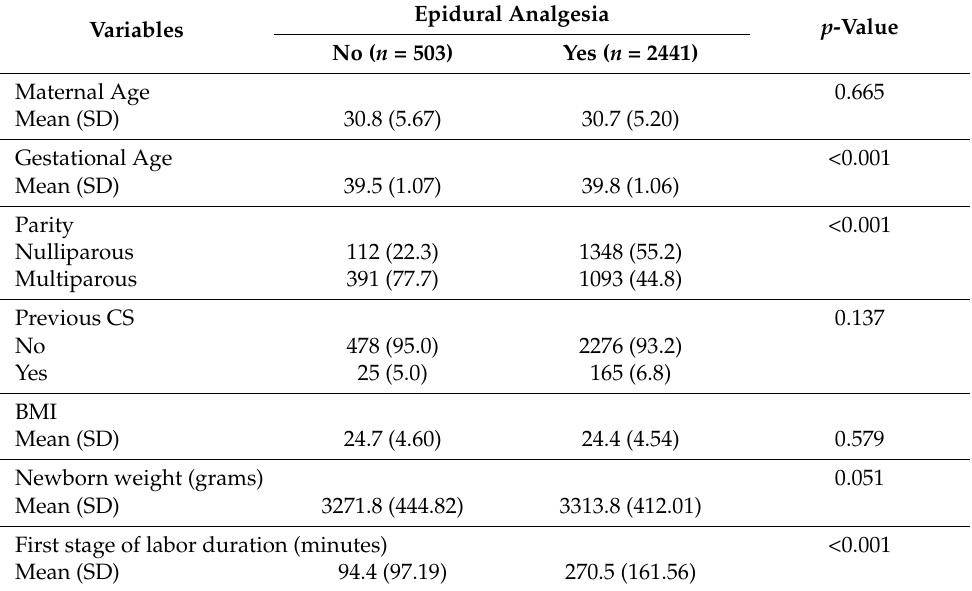
Table 1. Associated factors to epidural analgesia that can be presented as potential confounding factors in population